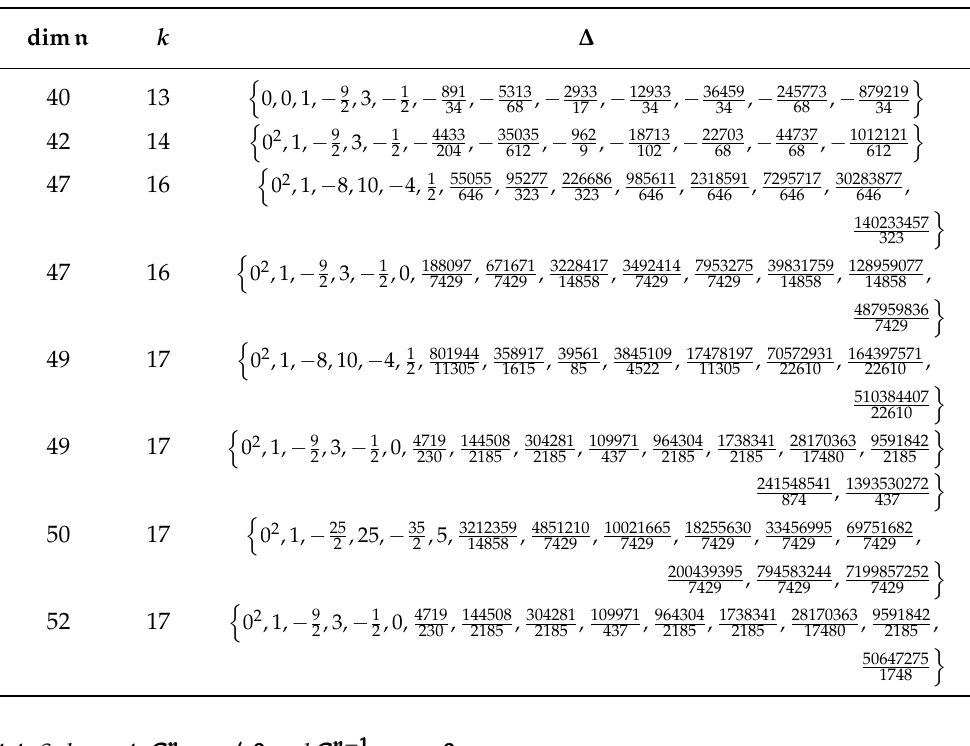
Table 4. Lowest-dimensional solutions with n ≤ 50 for Subcase